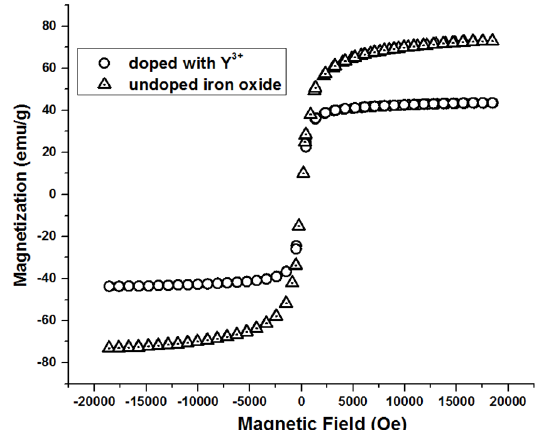
Fig. 4. Hysteresis loops for undoped and Y 3+ doped iron oxide nanoparticles